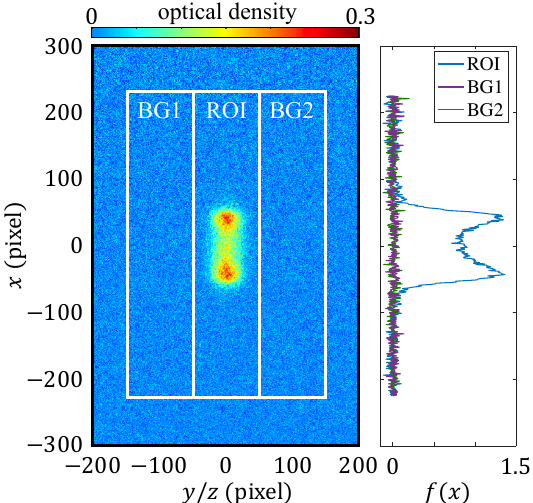
Figure 13: An example of the horizontal imaging. A region of interest (ROI) is ar- ranged to contain all atoms, and two background regions BG1 and BG2 are selected next to ROI. The pixel size is 6.45 µ m × 6.45 µ m in the object plane. To obtain the lon- gitudinal MDF and estimate the noise floor, we integrate the images in these regions over the transverse direction, respectively. The MDF (blue) and noise level (green and purple) are shown on the